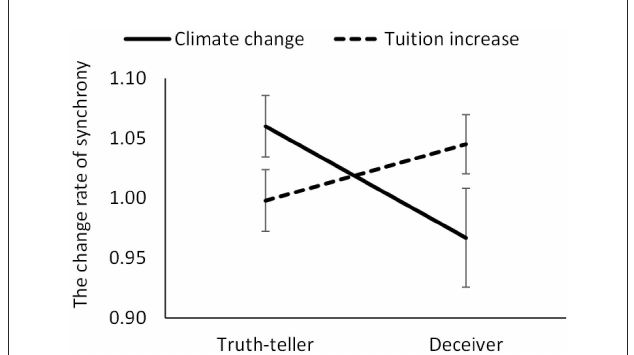
FIGURE2 Interaction effect between topic and veracity condition for the change rate of synchrony. A higher change rate of synchrony indicates that synchrony increased more sharply when moving from the first half of the conversation (when a discussion of what the participant and the partner liked about their university occurred) to the second half of the conversation (when a direct discussion of climate change or tuition increases